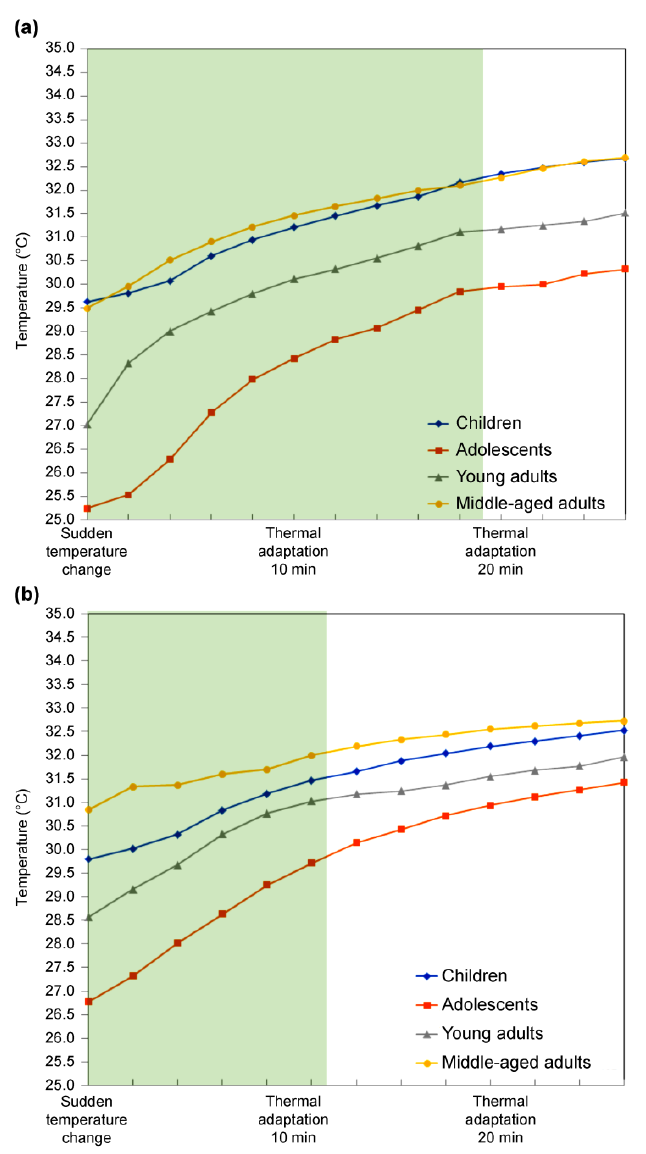
Figure 7. Changes in the mean skin temperatures of different age-groups exposed to (a) 18 °C and (b) 24 °C.